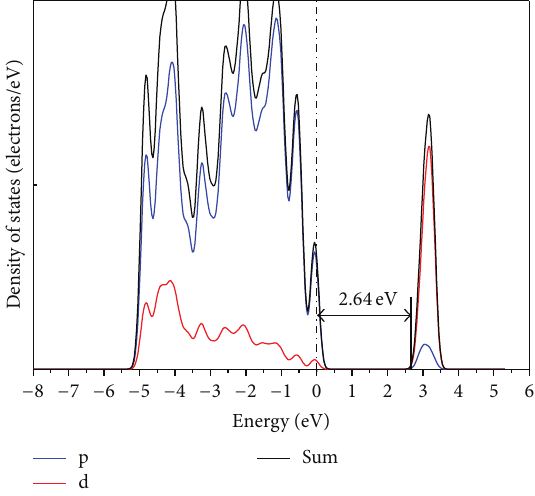
Figure 4: Density of the states (DOS) calculated for the pure surface Ti 24 O 48 (TO). Fermi level is at 0 eV and 𝑈 is 8.50 eV for Ti 3d